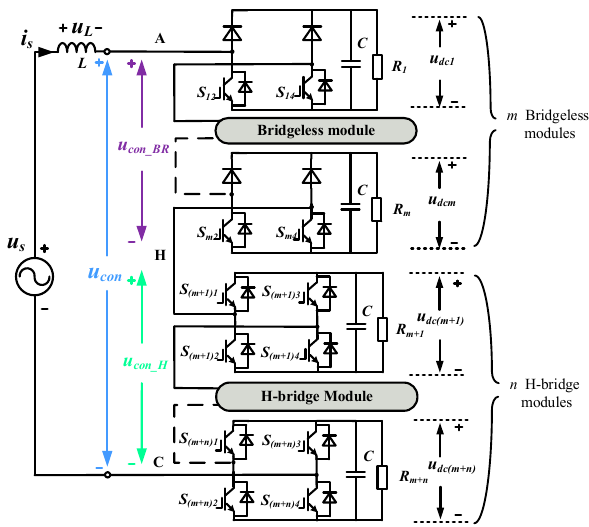
Figure 2. Topology of single-phase hybrid cascaded rectifier operation modes with m bridgeless modules and n H-bridge modules.